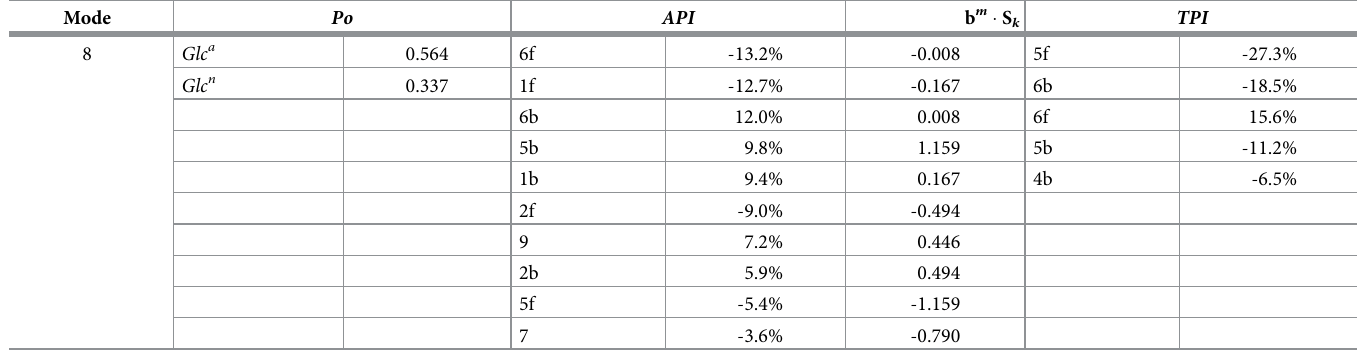
reactions 6f, 4b and 5b, which provide the smaller contributions; see the diagnostics in the second row of Tables 1 and 2. The third fastest mode along the Glucose path is the 5th and denotes the equilibration among the 1st, 4th, 5th and 6th reactions: ð 10 Þ The largest contributions in the cancellations occurring in this constraint originate from the two directions of the 6th reaction; this feature is more pronounced in the NALS case. The con- tributions of the two directions of the 1st reaction are the next largest and are similar in both cases. The smallest contributions originate from the 4th and 5th reactions; the ones of the 4th reaction being similar in the two cases and those of the 5th reactions becoming negligible in the NALS case. This is the first mode along the Glucose path in which notable differences are encountered in the ANLS and NALS cases; i.e., a decreasing contribution of the 5th reaction and an increasing one of the 6th reaction in the NALS case relative to the ANLS one. This fea- ture, that emerges when switching from the ANLS to the NALS case, is accompanied by the change in the way the Lactate path is coupled to the Glucose path. Specifically, in the ANLS case this coupling takes place in the astrocytes (where the 5th reaction is active) via the 7th reaction, while in the NALS case this coupling takes place in the neurons (where the 6th reac- tion is active) via the 9th reaction. This mode (5th) refers mainly to Glc int and secondarily to Glc e in the ANLS case and to Glc n in the NALS case. Glc int is the reactant of reaction 6f that provides the largest contributions to τ in both cases and of reaction 5b that provides a signifi- 5 cant contribution in the ANLS case. The last fast mode along the Glucose path is the 8th and emerges only in the context of the ANLS case. This mode denotes the equilibration among the 5th, 6th and 7th reactions: ð 11 Þ and refers mainly to Glc a and secondarily to Glc n . Glc a is the reactant of reaction 5f that pro- vides the largest contribution to τ , while Glc n is the reactant of reaction 6b that provides the 8 next largest contribution. Table 2 shows that in the NALS case the 8th mode is not exhausted (since no large cancellations among the APIs are evident). However, the pointed variables and the reactions contributing to τ are the same. As Fig 2 shows, this mode is not exhausted 8 because τ is significantly slower in the NALS case, compared to the ANLS 8